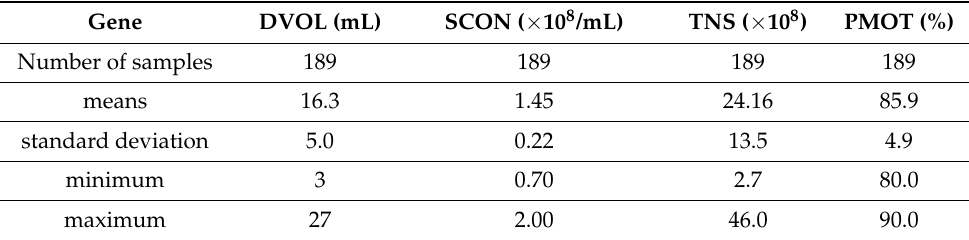
Table 3. Descriptive statistics for the semen quality